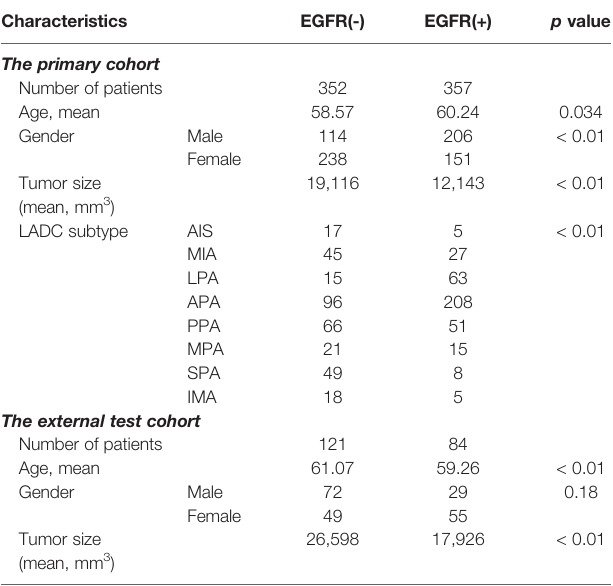
TABLE 1 | Demographic and clinical characteristics of LADC patients.